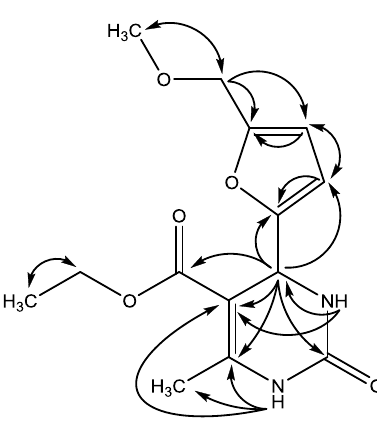
Figure 3. Selected HMBC correlation for compound 4 .